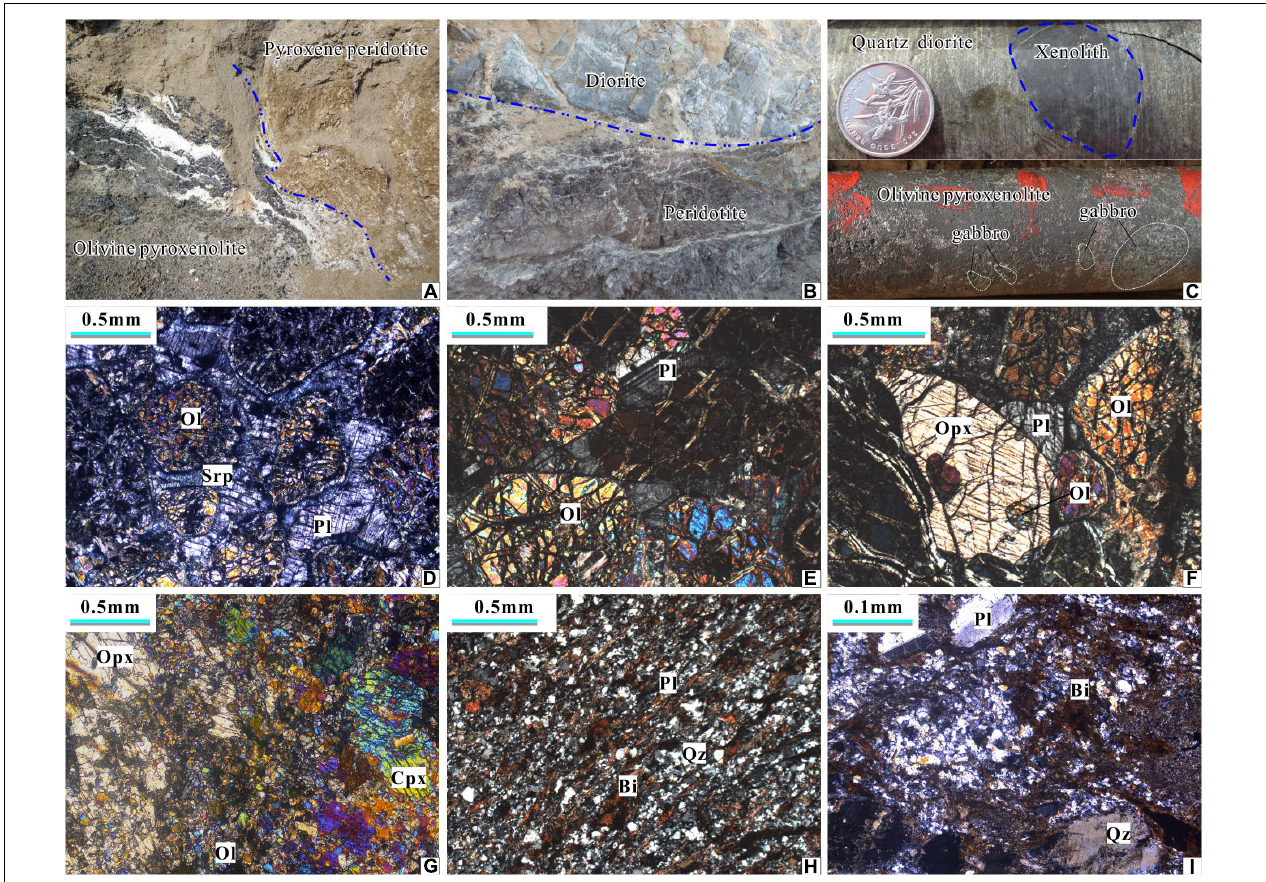
FIGURE 3 | Photos of outcrops and microphotographs of representative rocks from Lubei deposit. (A) contact relationship between olivine pyroxenite and pyroxene peridotite; (B) contact relationship between diorite and peridotite; (C) wall–rock xenoliths in quartz diorite and gabbro xenoliths in olivine pyroxenite; (D) serpentinized peridotite; (E) pyroxene peridotite; (F) pyroxene peridotite; (G) fragmented olivine pyroxenite; (H) slightly deformed quartz diorite; (I) deformed quartz diorite with porphyritic texture. Ol, olivine; Opx, orthopyroxene; Cpx, clinopyroxene; Pl, plagioclase; Srp, serpentine; Bi, Biotite; Qz,